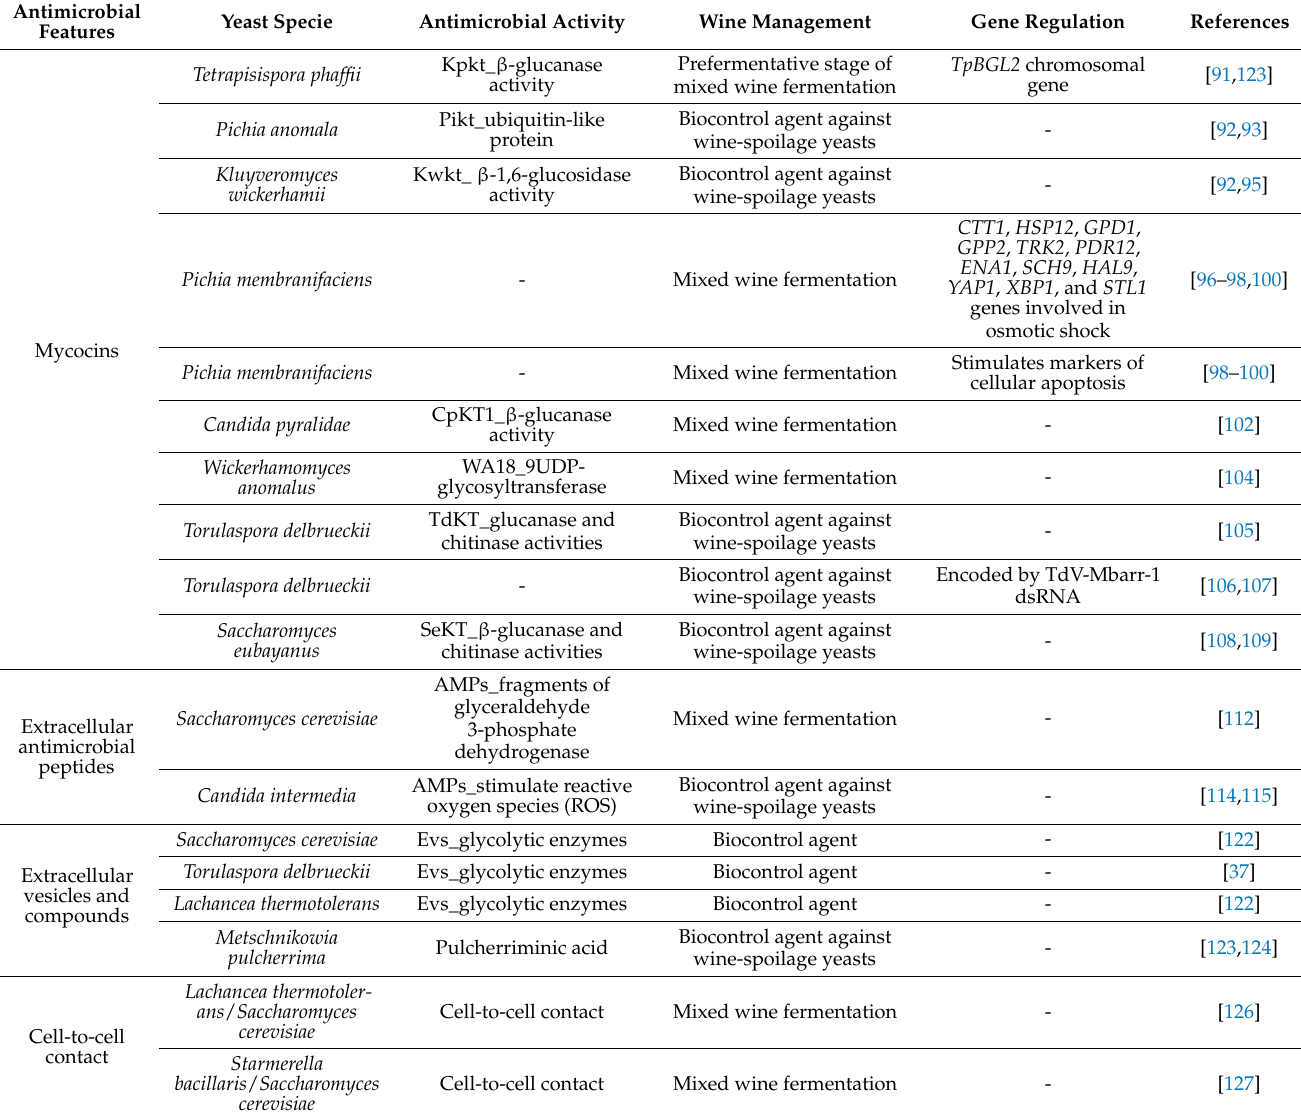
Table 4. Main antimicrobial activity in yeast–yeast